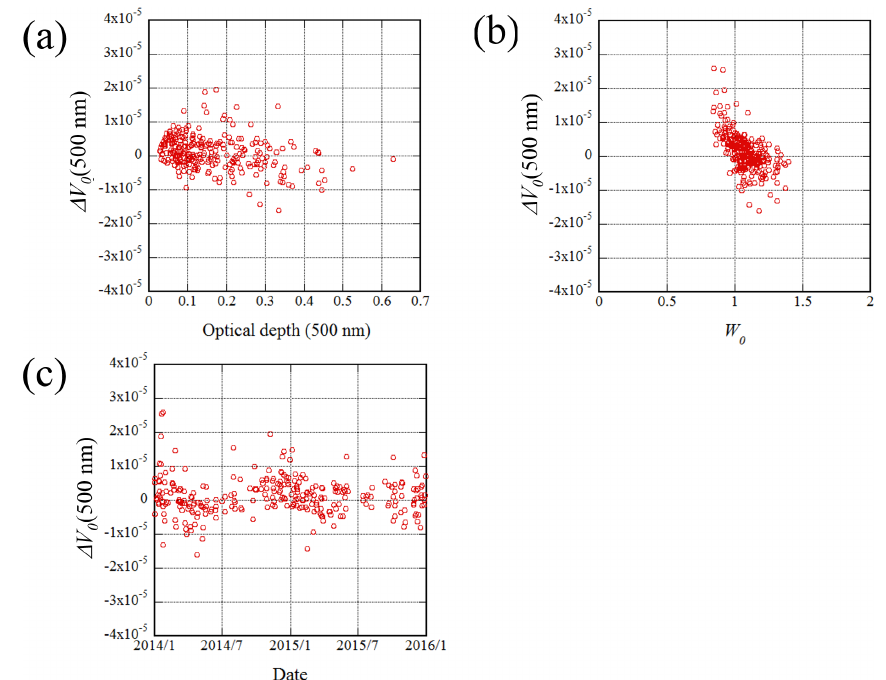
Figure 9. (a) Scatter plot of (cid:49)V 0 for the 500nm channel and the optical depth at 500nm. (b) Scatter plot of (cid:49)V 0 and W 0 for the 500nm channel. (c) Time series of (cid:49)V 0 for the 500nm channel from January 2014 to December 2015. (cid:49)V 0 is the difference between V 0 determined by the IML method and V 0 interpolated from V 0 , determined by inter-comparison with POM-02 (calibration reference). The unit of V 0 and (cid:49)V 0 is ampere